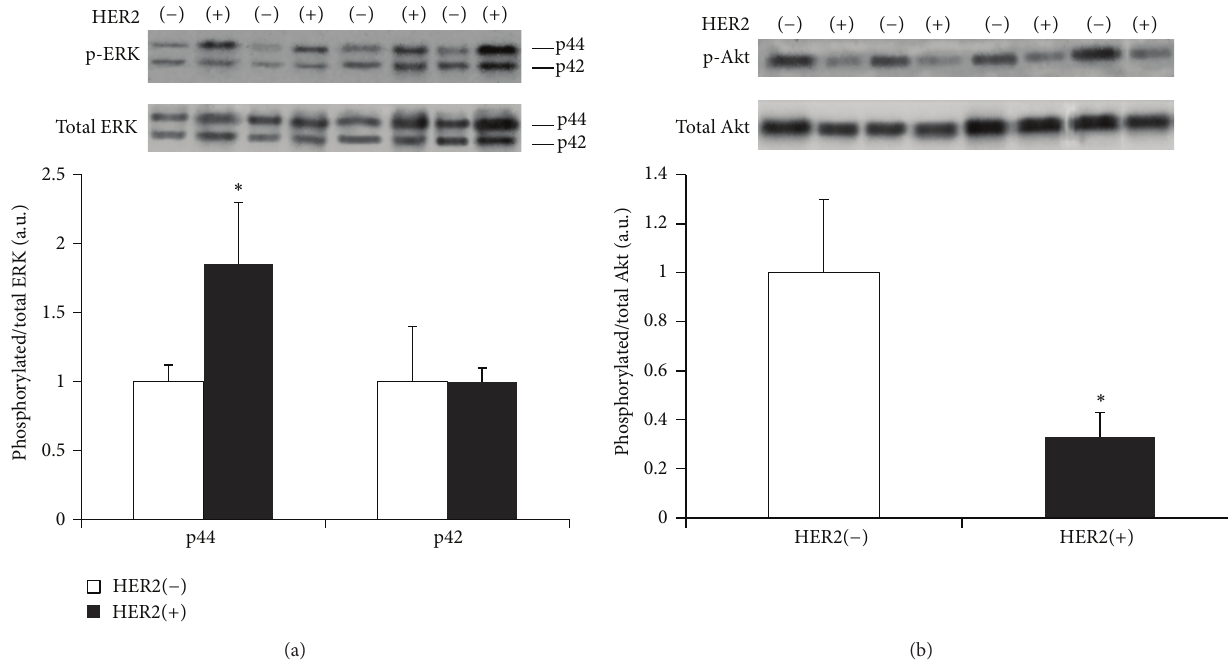
Figure 3: Densitometric assessment and representative Western blots of p44 and p42 phosphorylated ERK/total ERK (a) and phosphorylated Akt/total Akt (b) are shown in breast cancer patients with HER2( − ) and HER2(+) tumors. ∗ 𝑃 < 0.05 versus HER2( −